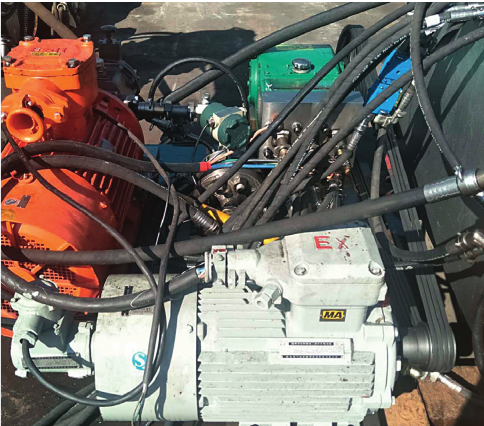
Figure 15: Three plunger linear motor.